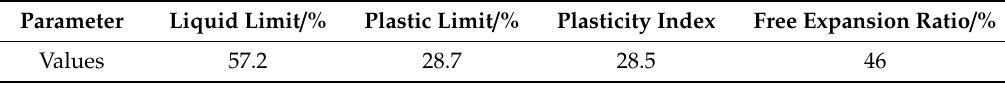
Table 2. Physical characteristics of expansive